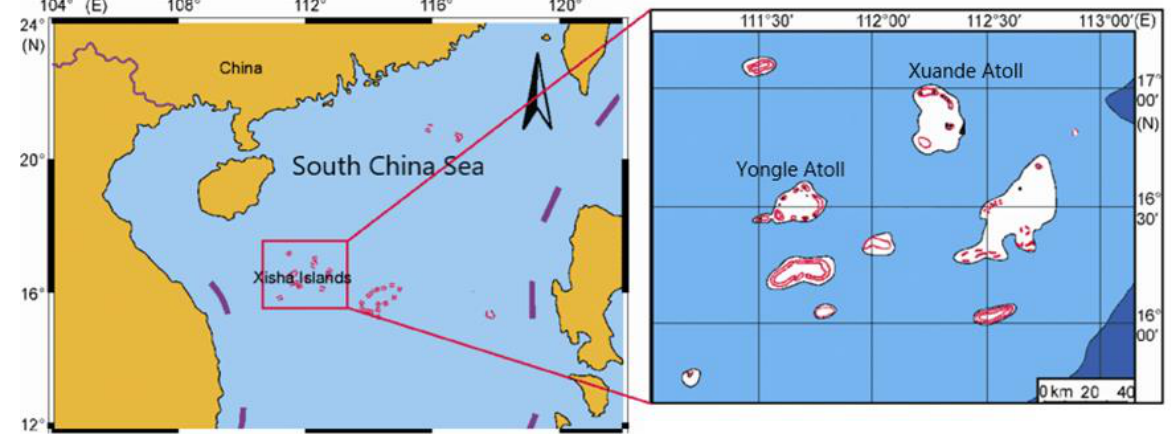
Figure 1. Map of the Xisha Islands in the South China Sea.